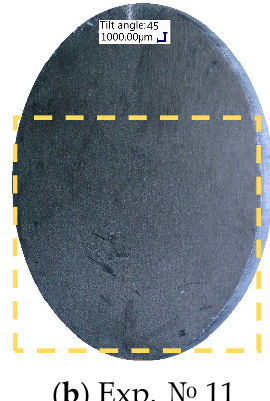
Figure 5. Microscope images of the O1 sample surface at 45° observation angle ( a ) after the fifth condensation experiment at 4 g/min steam flow rate, and ( b ) after the first condensation experiment at 6 g/min steam flow rate.